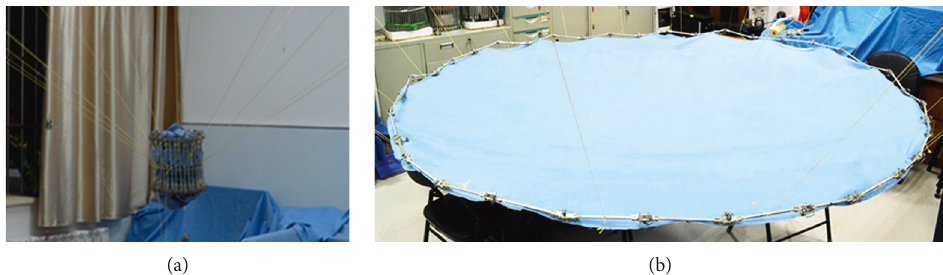
Figure 30: Deployment experiments of the folded hoop on the ground: (a) stowed status; (b) deployed status.